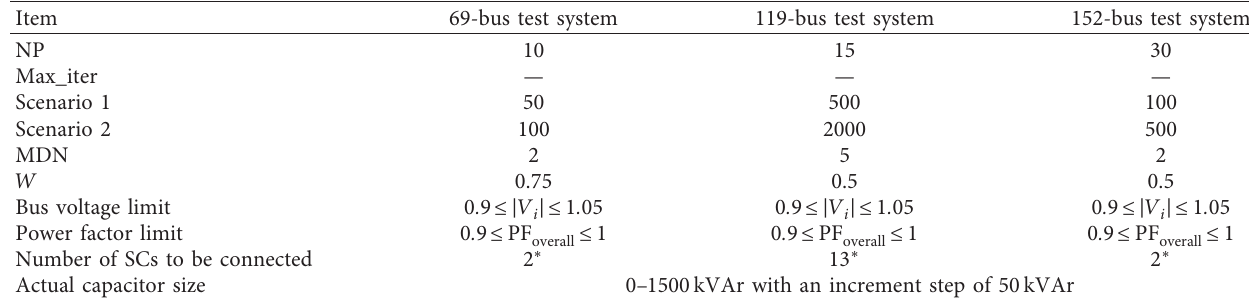
Table 2: Algorithm parameters and inequality constraint settings.